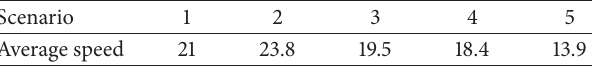
Table 3: Average bus travel speeds (km/h) in five scenarios along Eastbound Shengli road.